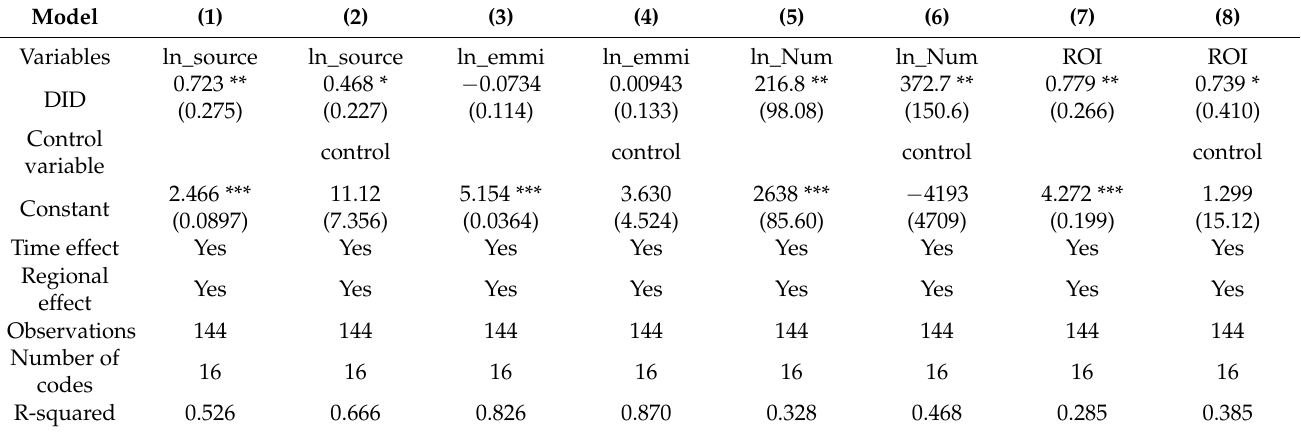
Table 6. Statistical table of regression results (3) 1